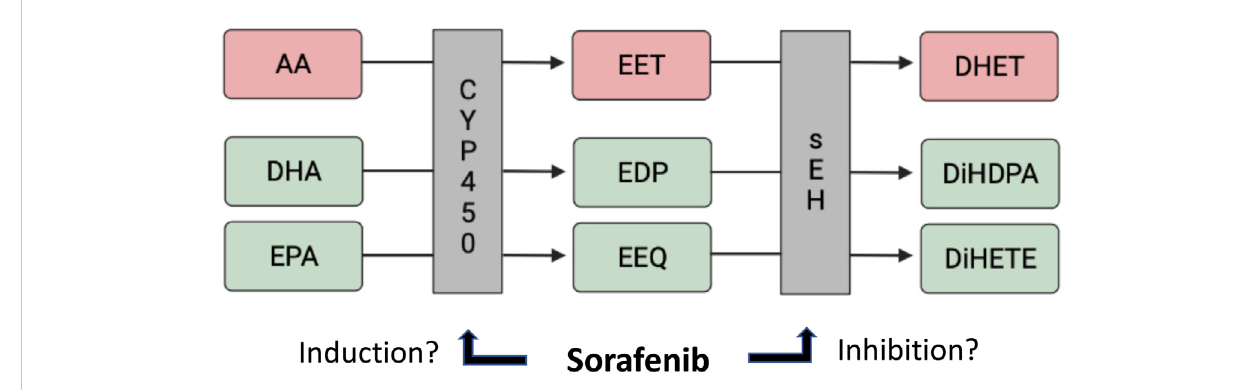
FIGURE 1 CYP-dependent lipid metabolite formation from AA/DHA/EPA, and the potential effects of